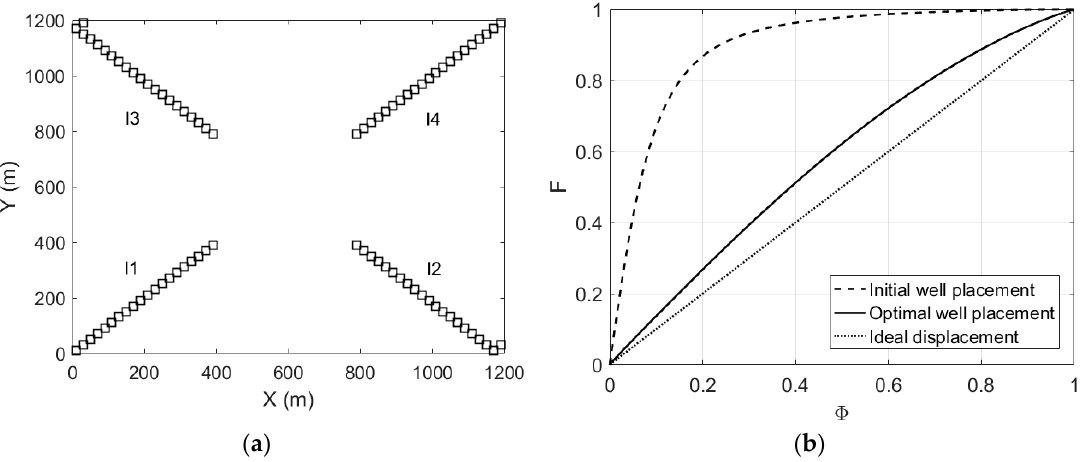
Figure 4. The results of the two-dimensional homogeneous aquifer test problem: ( a ) moving positions of the injection wells during the S/O iterations. ( b ) F ( Φ ) diagrams for the initial and optimal well positions.